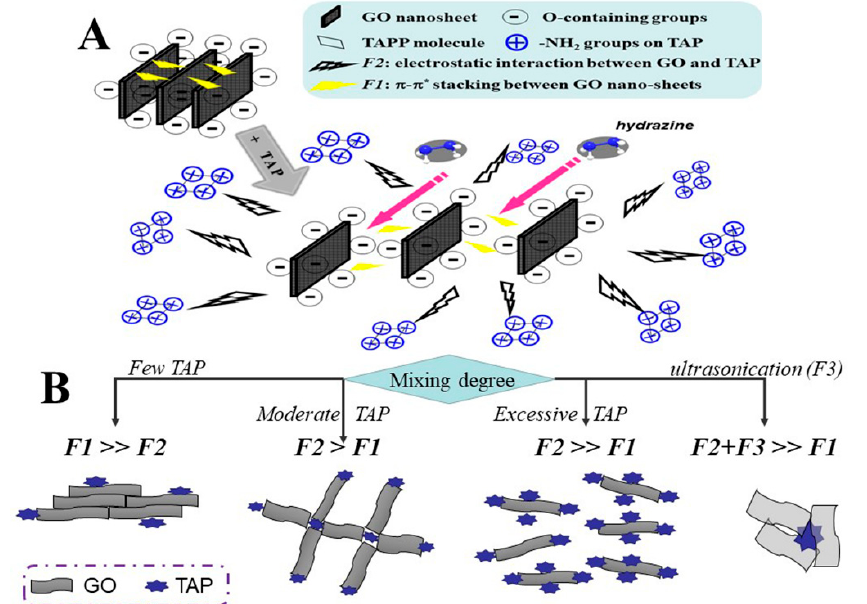
Figure 5. Schematic illustrations for approaches of TAP impacting rGO. ( A ) The interaction between GO and TAP. ( B ) The competition between the GO layers’ π – π * stacking force ( F1 ), TAP’s electrostatic attraction to GO ( F2 ), and ultrasonication-induced external impact force ( F3 ).